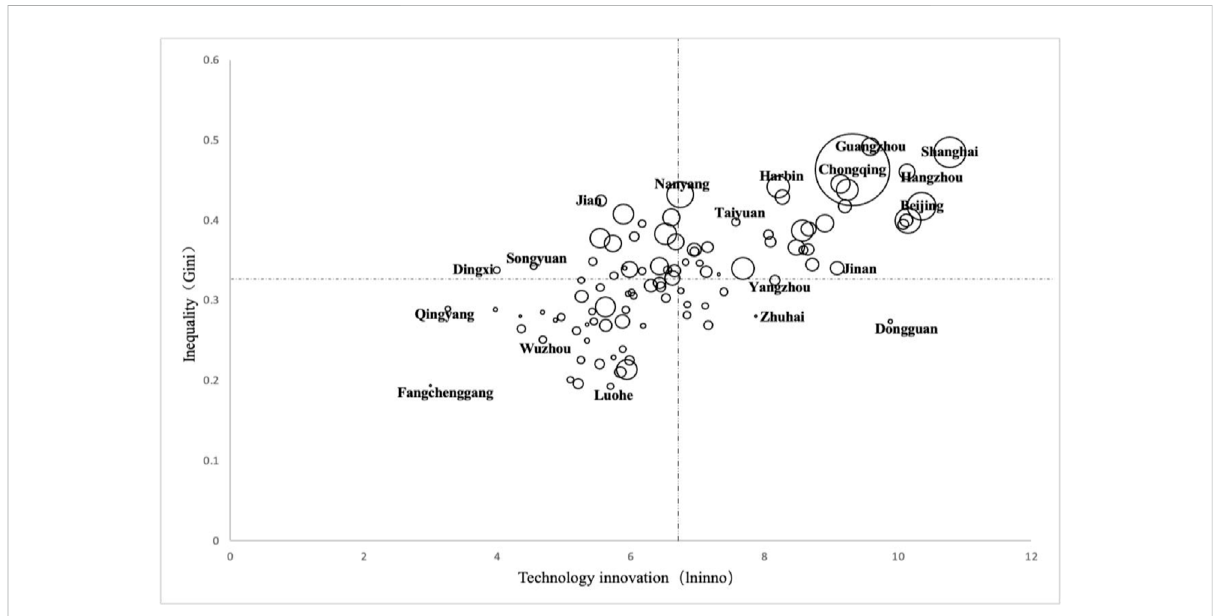
FIGURE 3 Gini coef fi cient, city size, and technological innovation (2010).